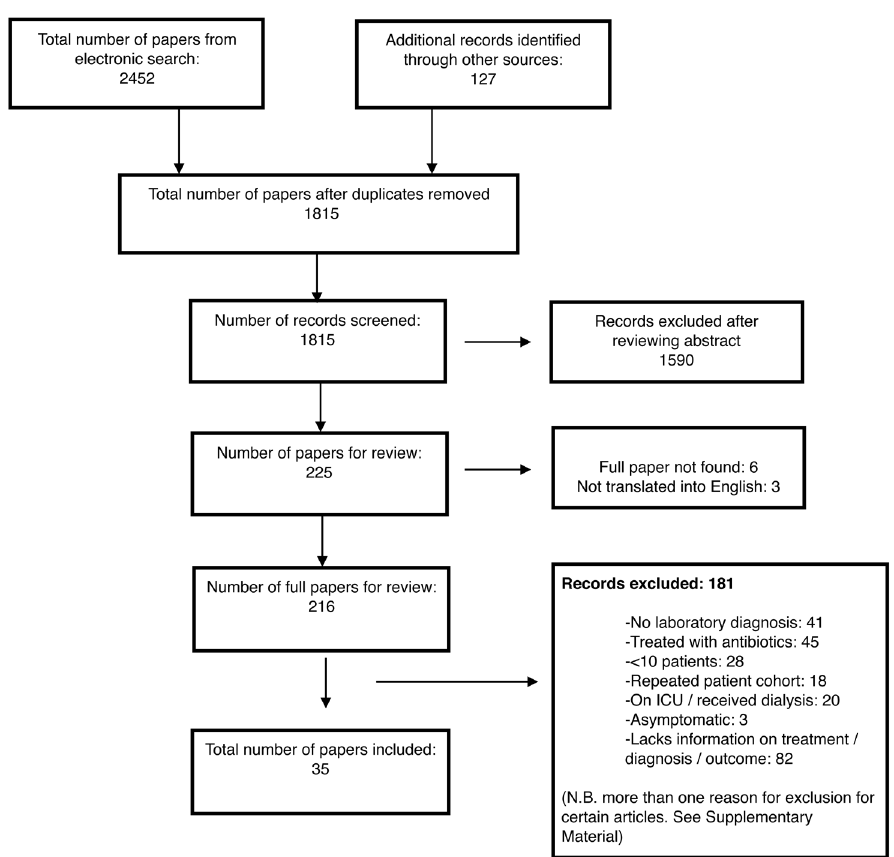
Fig 1. Flow diagram for selection of studies included in the